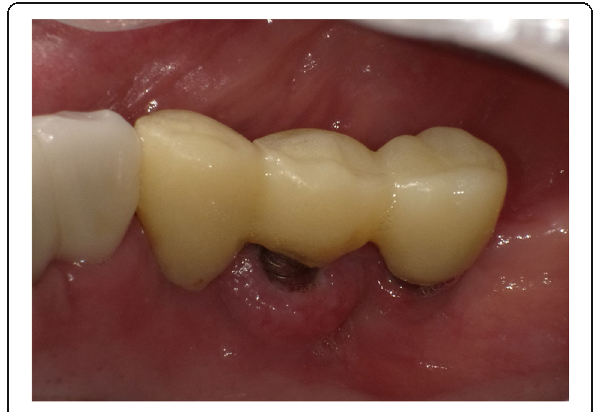
Fig. 1 Well-circumscribed gingival swelling on the lingual side of the right side of the